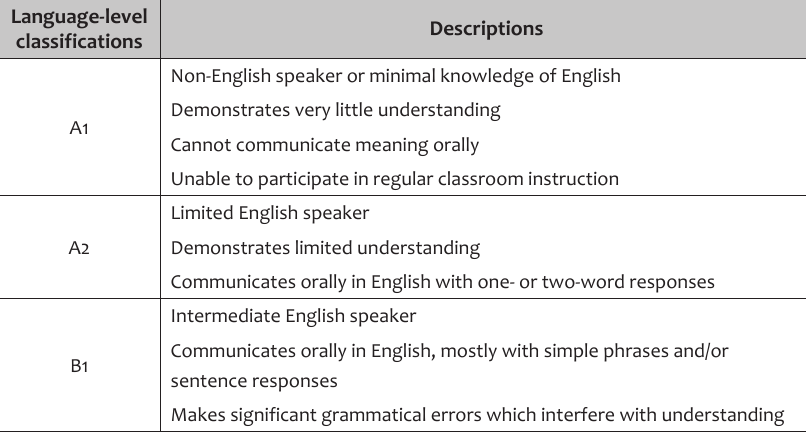
Table 10: Broward County language-level classifications and descriptions (Source: Broward County